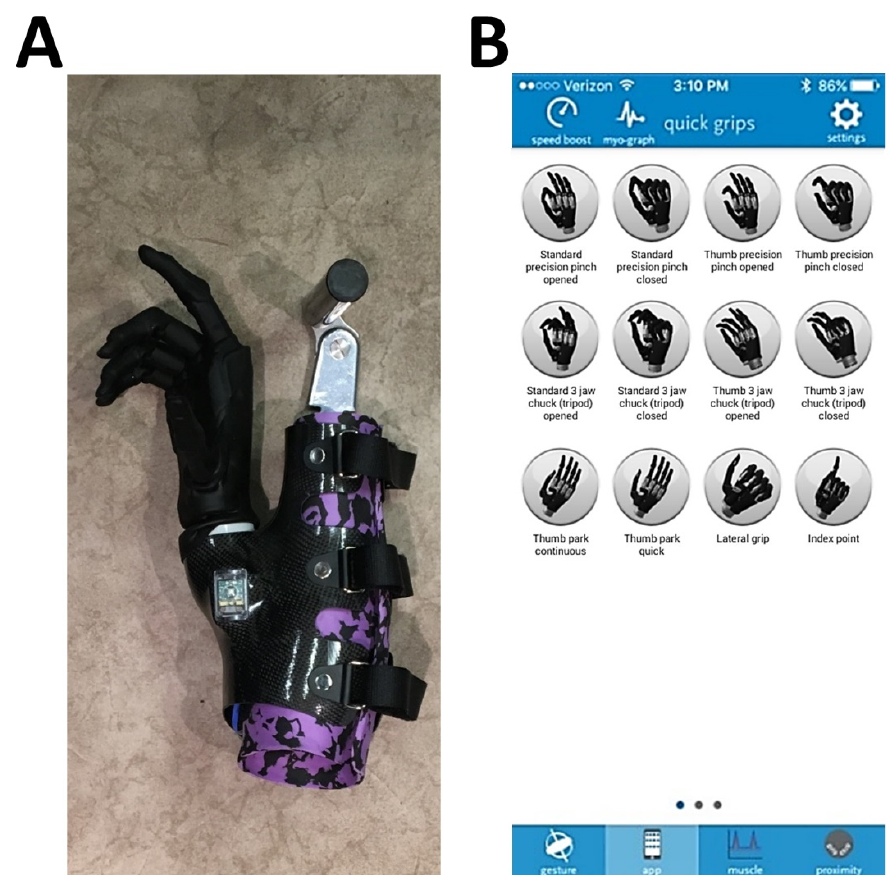
Figure 1. ( A ) Right-hand Ossur (TouchBionics) i-limb Ultra myoelectric terminal device. Medial off- set = 15°; ( B ) my i-limb grip selection screenshot (Touch Bionics, Apple App Store,